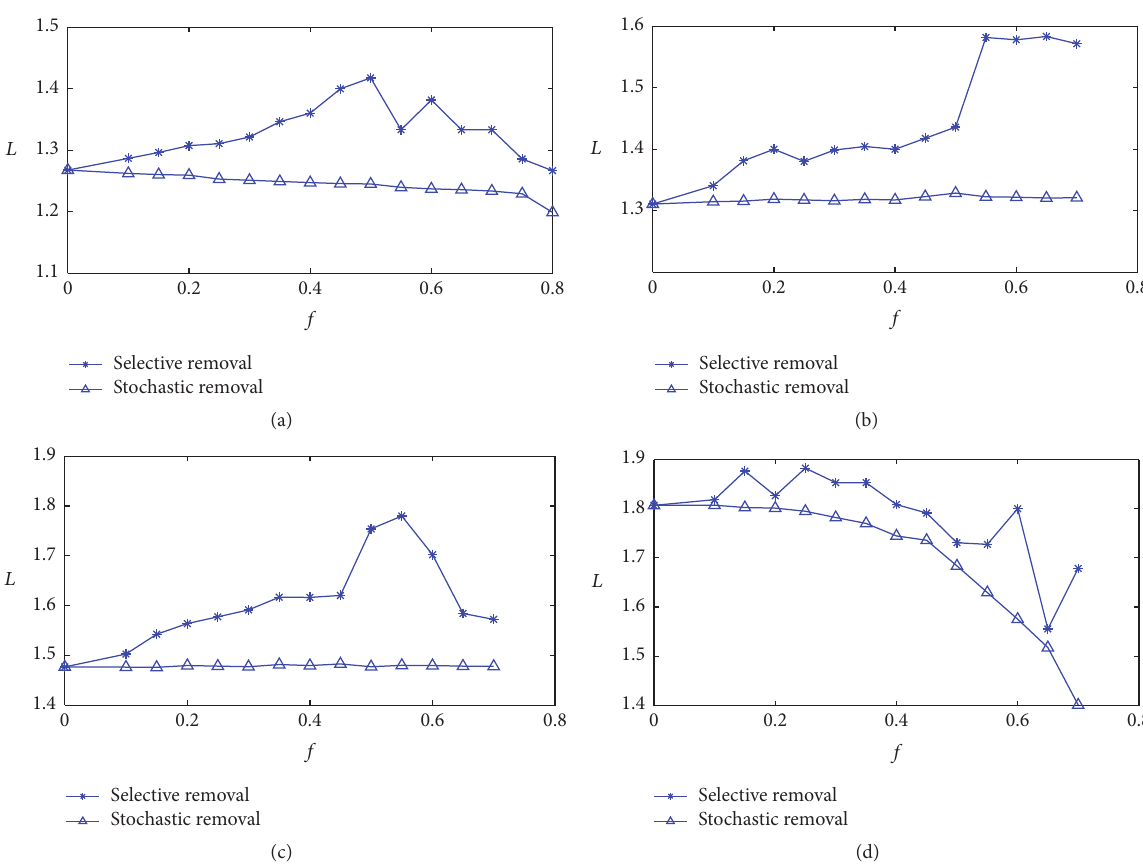
between China and other countries from W1 to W5 is 0.193, so here we choose the 𝜃 = 0.193 to construct the network. The network topology diagrams of the five data sets at 𝜃 = 0.193 are shown in Figures